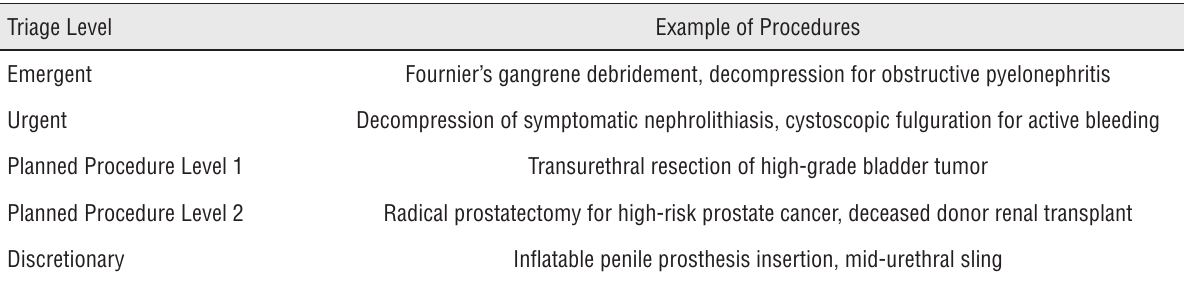
Table 1 - Triage levels used to determine case urgency during the COVID-19 pandemic with corresponding urologic procedures (non-exhaustive